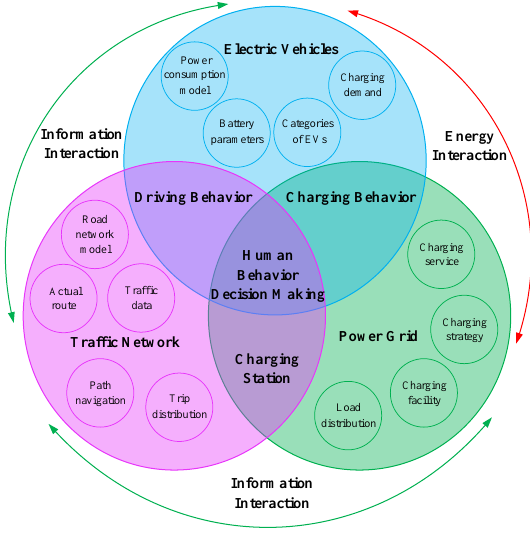
Figure 1. Fusion architecture of ‘Electric vehicle s – Power grid – Traffic network’.